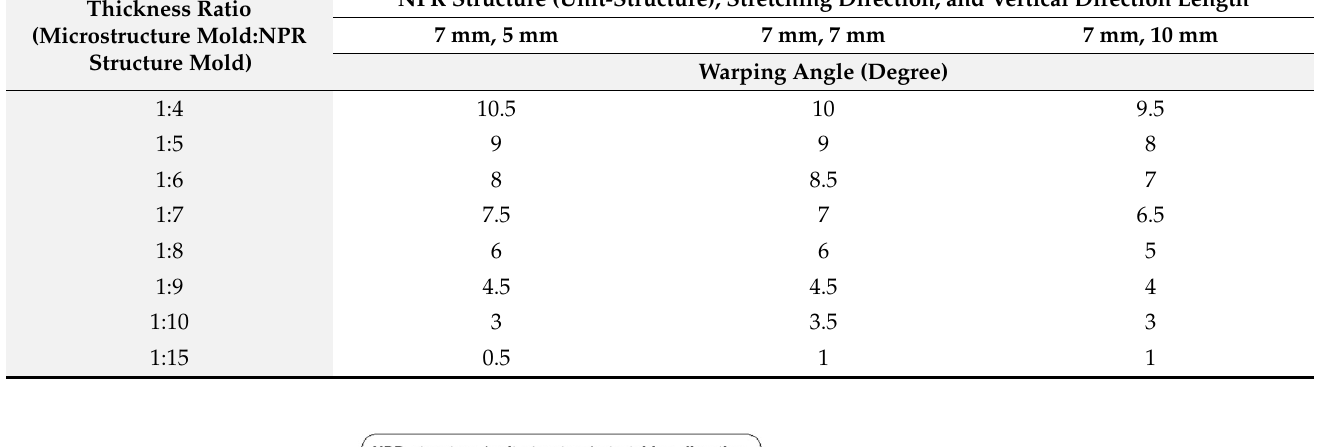
Table 4. Simulation results of the warping angle perpendicular to the stretching direction at a fixed stretching length with different NPR structure mold dimensions.